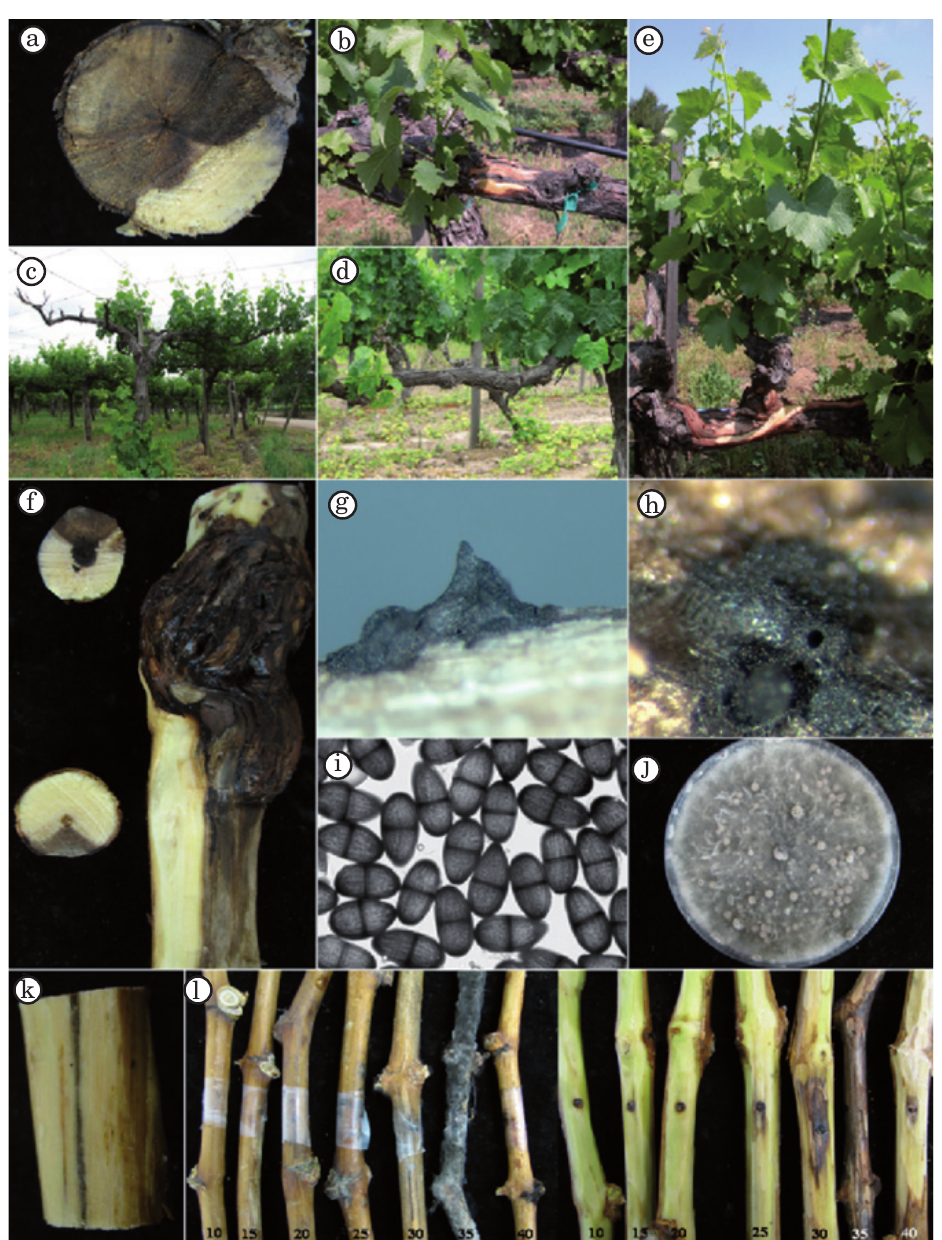
Figure 3. Botryosphaeria canker. a. Perennial canker (wedge-shape) in the trunk. b. Cankers generally develop from pruning wounds. c and d. Lack of spring growth is commonly observed in vines affected by Botryosphaeria canker. e. Normal and healthy growth can also be observed in vines affected by the disease. f. Infections can occur at the graft union causing wedge-shape cankers in both scion and rootstock. g–k. Lasiodiplodia theobromae , one out of the 19 botryosphaeriaceous fungi isolated from cankers. g. Pycnidia erupting through the bark. h. Aerial view of pycnidium showing the ostiole from which conidiospores are released. i. Conidiospores of L. theobromae . j. Characteristic colony morphology of L. theobromae on potato dextrose agar. k. Several species such as Botryosphaeria dothidea , Diplodia mutila , and Neofusicoccum parvum also cause dark streaking of the wood. l. Effect of seven different temperatures (°C) on the length of vascular discoloration caused by L. theobromae